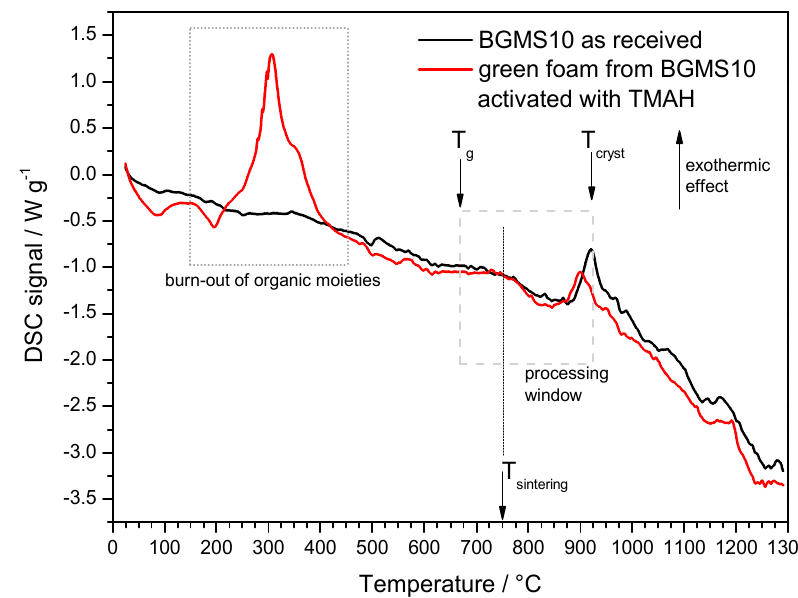
Figure 3. DSC plot of BGMS10 glass in the as received conditions and in the form of ‘green’ foam. All printed samples were opaque white as an e ff ect of the presence of tiny micropores (see the